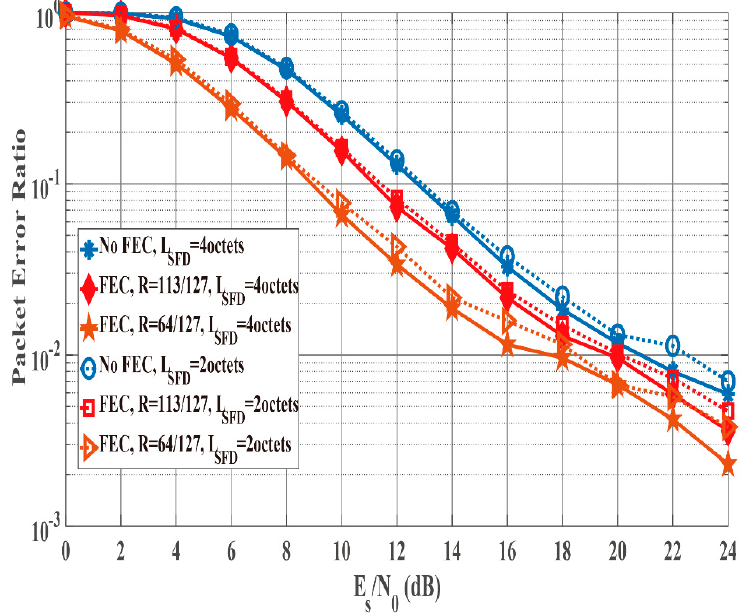
Figure 14. PER performance as a function of E s / N 0 ( K factor = 4.5). Case with an SFD ( L SFD = 2 octets and 4 octets).